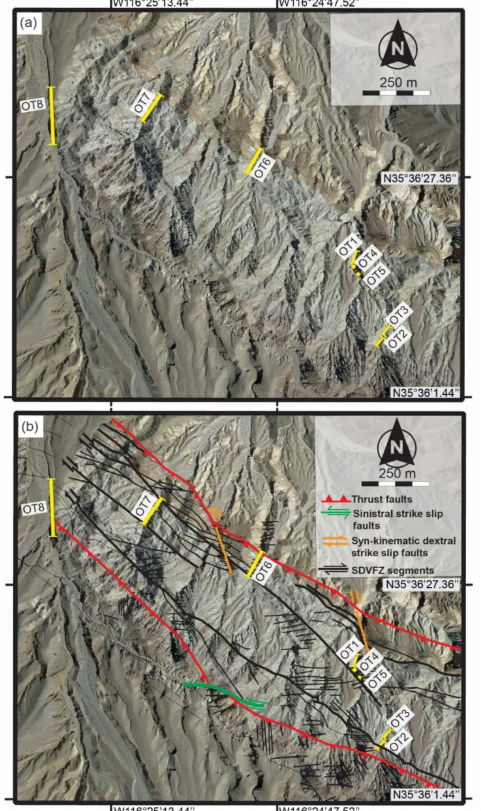
Figure 2. ( a ) Map highlighting the structural position of the central part of NH, including the outcrops (OT) location and ( b ) SDVFZ segments position in black, syn-kinematic dextral strike slip faults in orange, sinistral strike-slip faults in green lines, and thrust faults in red. Dextral strike slip faults are syn-kinematic with SDVFZ episode, those systems are followed by thrust faults, which are contemporaneous with the GFZ orientated globally